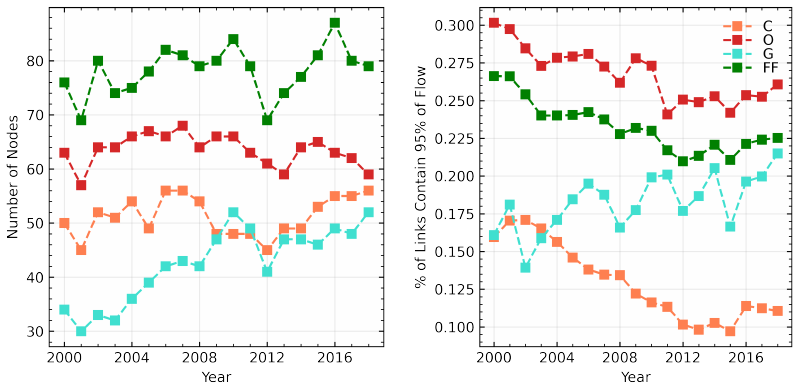
Figure 8. Changes in the number of nodes and links accounting for 95% of